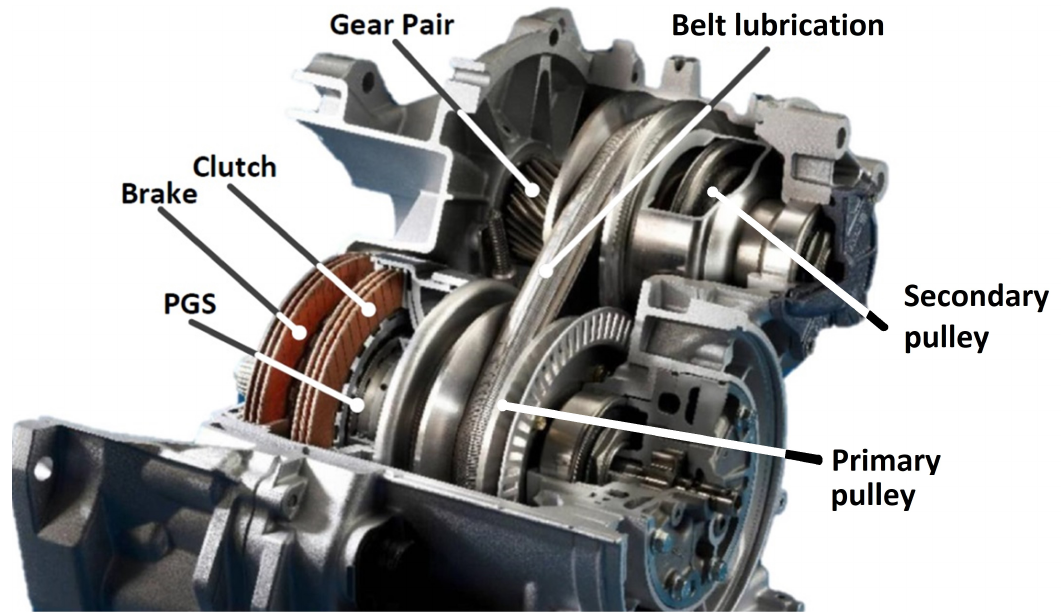
Figure 1. Continuously variable transmission (CVT) technology (courtesy of Punch Powertrain).